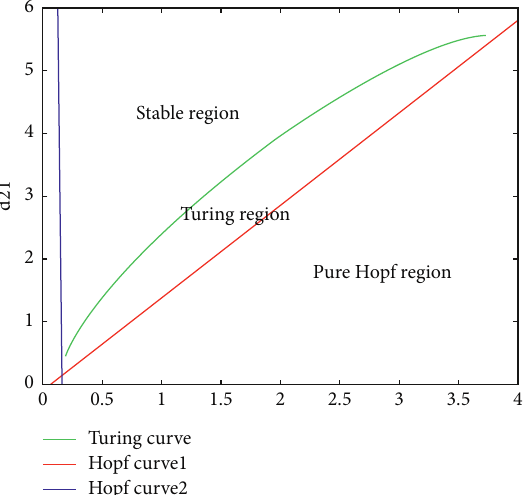
Figure 8: Bifurcation diagram in d